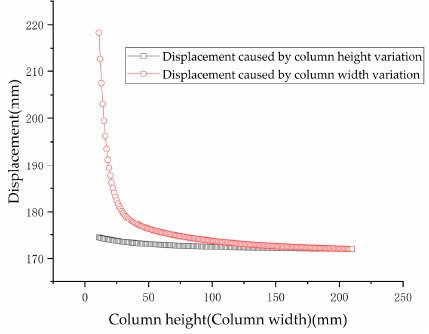
Figure 6. Sensitivity curve of B M plate thickness.